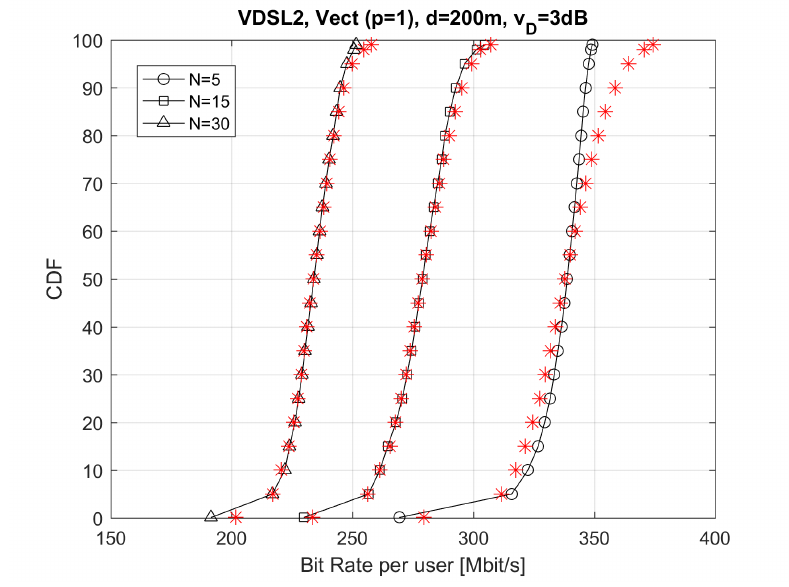
Figure 3. CDFs of the vit rate per user in the vectoring case ( p = 1): d = 200 m, and variable N . Exact (solid) and Gaussian approximation (asterisks) results are